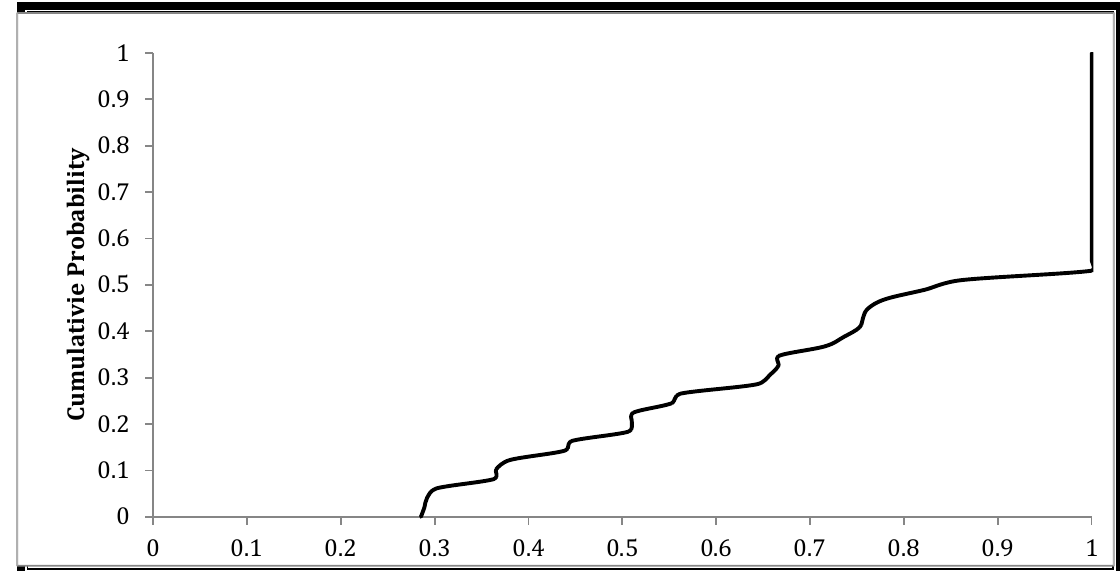
Figure 2. Cumulative probability distribution of technical efficiency scores.